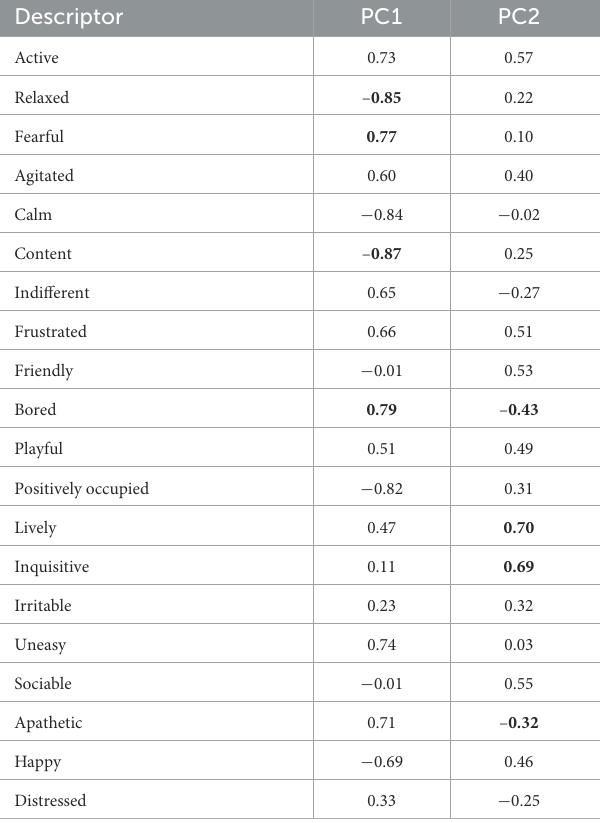
TABLE 3 Group 2: Principal components 1 and 2, displaying associated correlations between variables and principal components for each behavioural